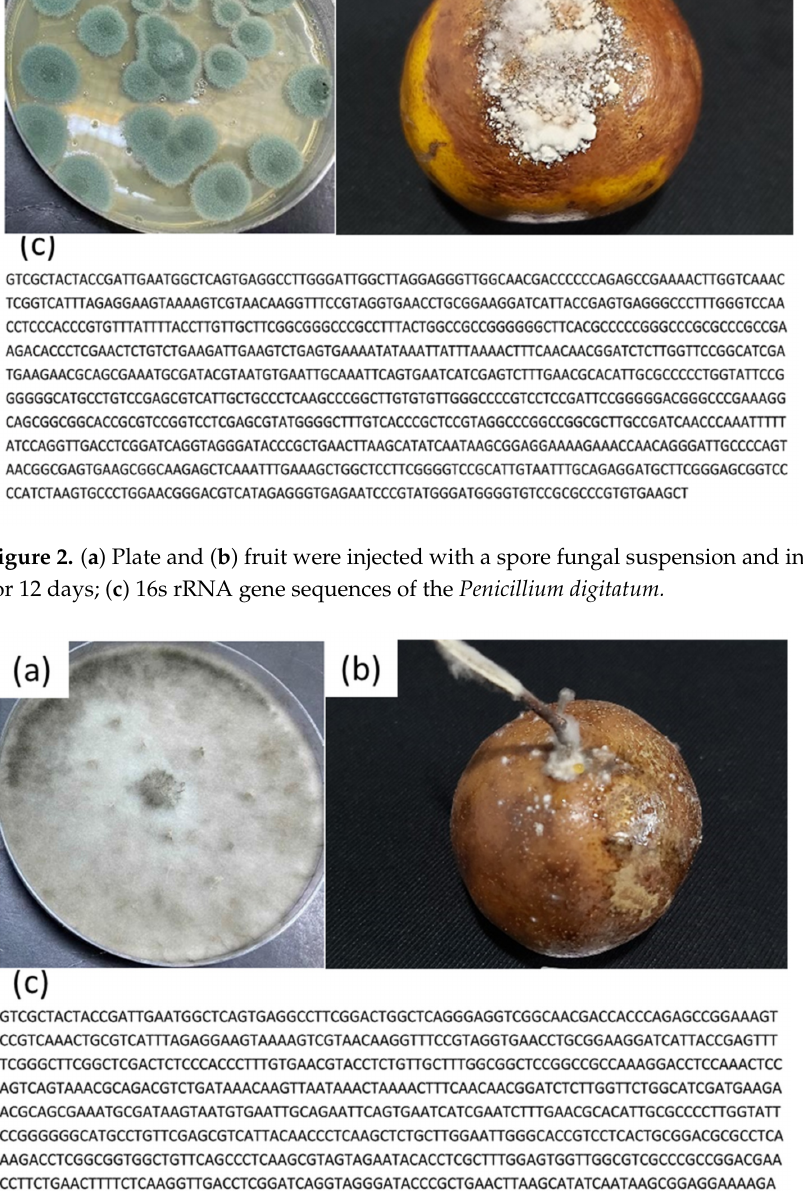
Figure 3. ( a ) Plate and ( b ) fruit were injected with a spore fungal suspension and incubated at 30 ◦ C for 12 days; ( c ) 16s rRNA gene sequences of the Lasiodiplodia